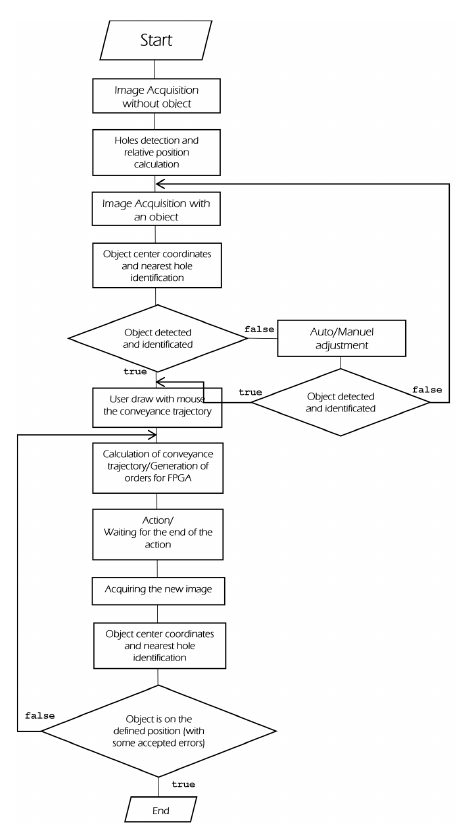
Figure 11. The IPDC unit flowchart.